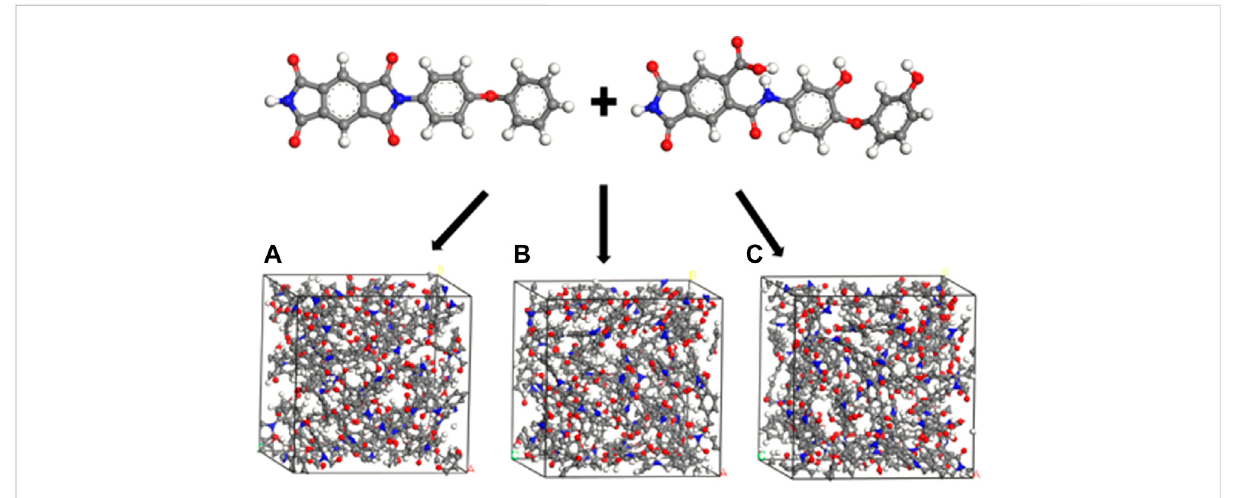
FIGURE 10 (A – C) are plasma modi fi ed polyimide models, the difference is that the proportions are different. (A) represents 10% modi fi ed proportion, (B) represents 20% modi fi ed proportion, and (C) represents 30% modi fi ed proportion, which has been mentioned in the paper, The title can serve as an